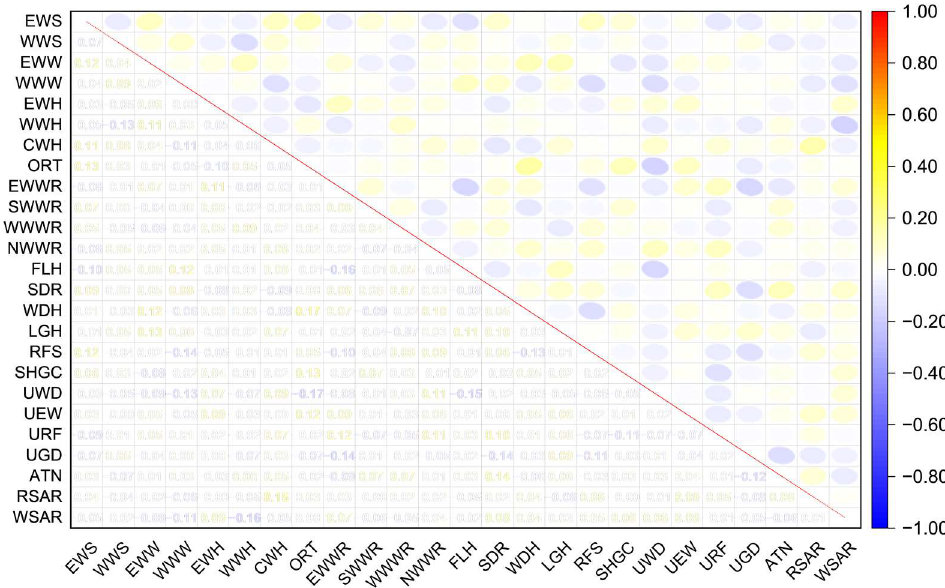
Figure 5. The correlation between 25 variables expressed by Pearson correlation coefficient.